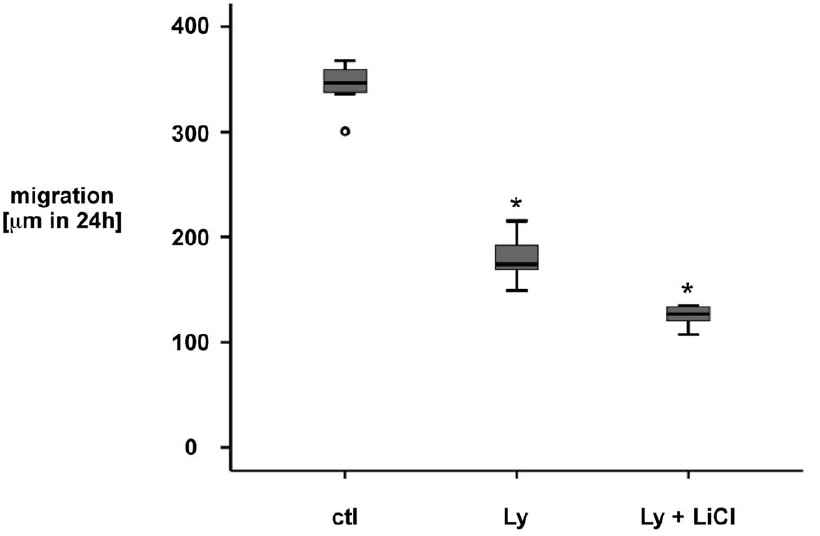
Figure 5. IEC18 cell monolayer restitution in response to wounding is dependent on PI3K signaling. Confluent IEC18 cell monolayers were pretreated for 30 minutes with the specific inhibitor of PI3K activation Ly294002 (Ly, 25 m M) or solvent control, standardized wounds were created using a razor blade and restitution was monitored over 24 h using serial microphotography. In a separate set of experiments, the GSK3ß inhibitor Lithium Chloride (LiCl, 20 mmol/l, pretreatment of an additional 30 minutes before exposure to Ly) was used to inhibit GSK3ß kinase activity in Ly294002-treated cells. Ly294002 significantly inhibited wounding-induced restitution as compared to control-treated cells, which was not reversed by LiCl-treatment. Data are expressed as median and interquartile range (IQR) of n=9 independent wounds per condition. Statistical analysis was performed by the Kruskal-Wallis test for non-parametric data (*p , 0.05 versus control).